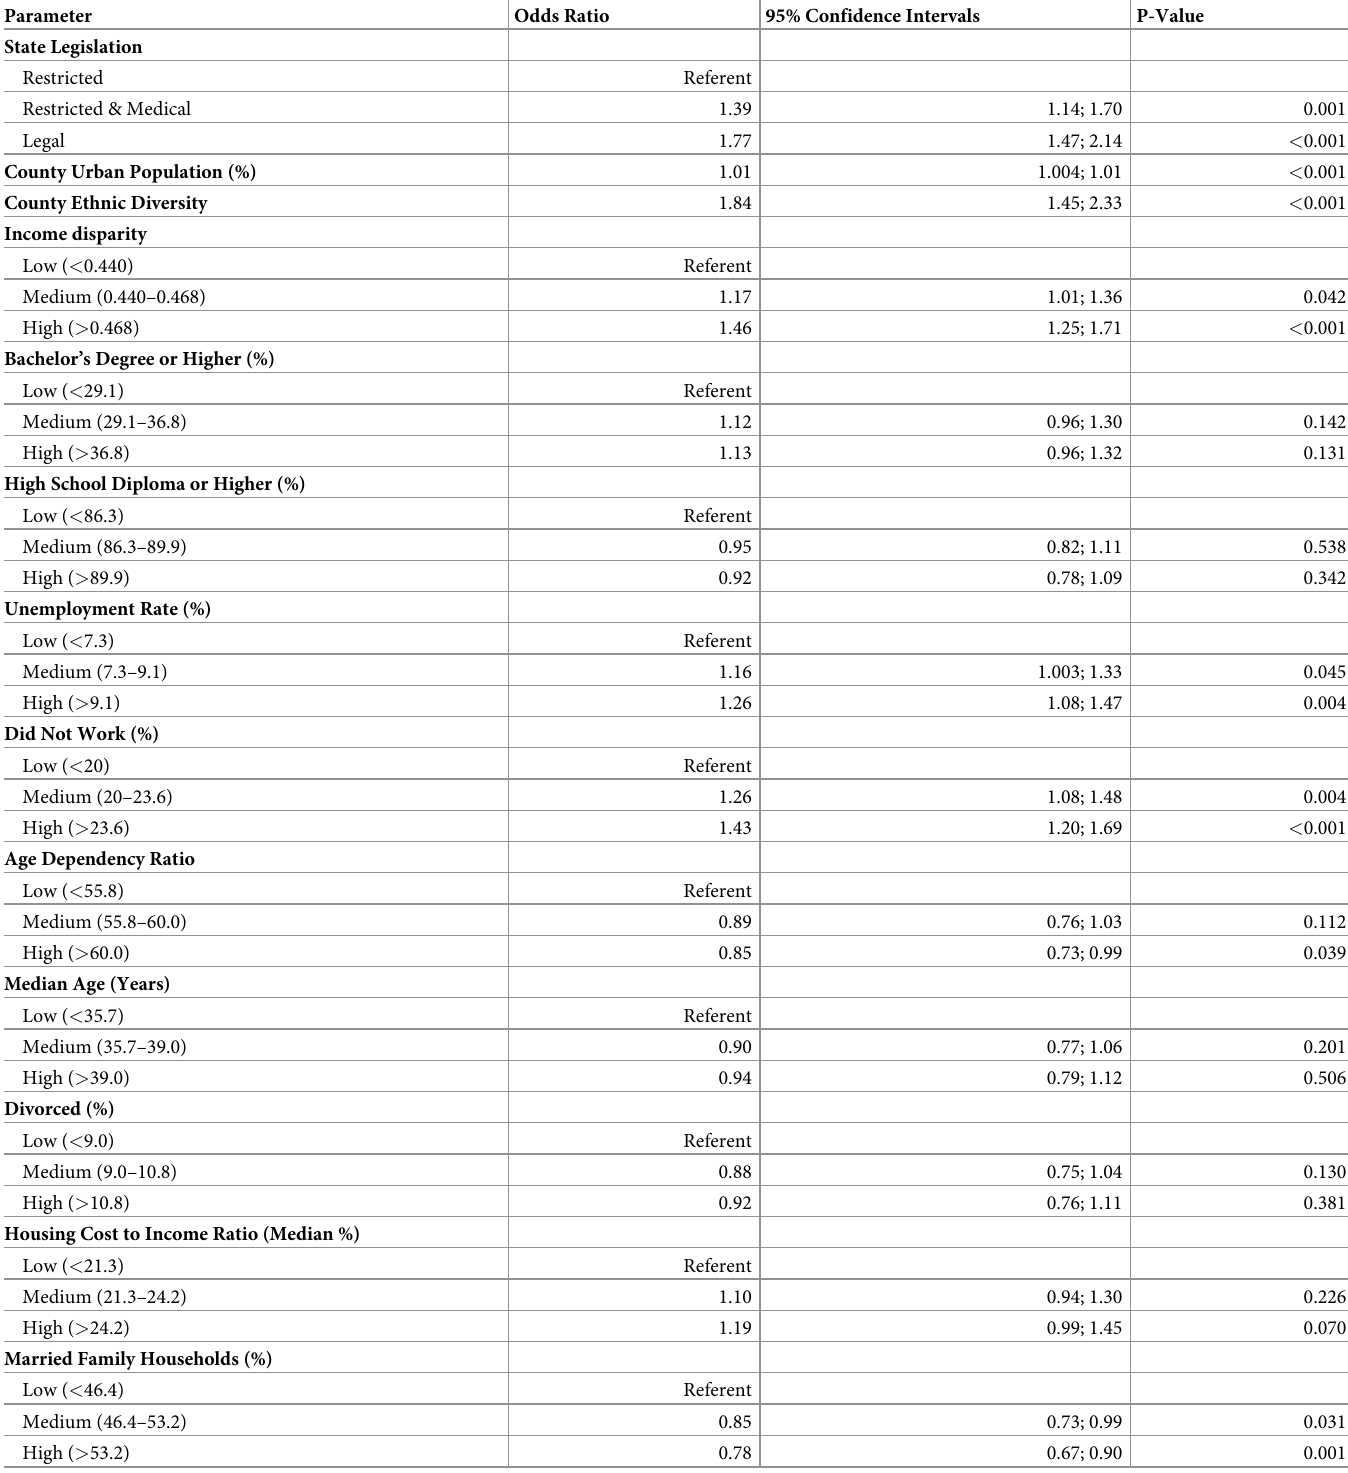
Table 6. Results of univariable mixed logistic regression models † examining the associations between each individual community-level variable on the odds of a US dog-associated poisoning call to the APCC a being related to cannabis (2009–2014).